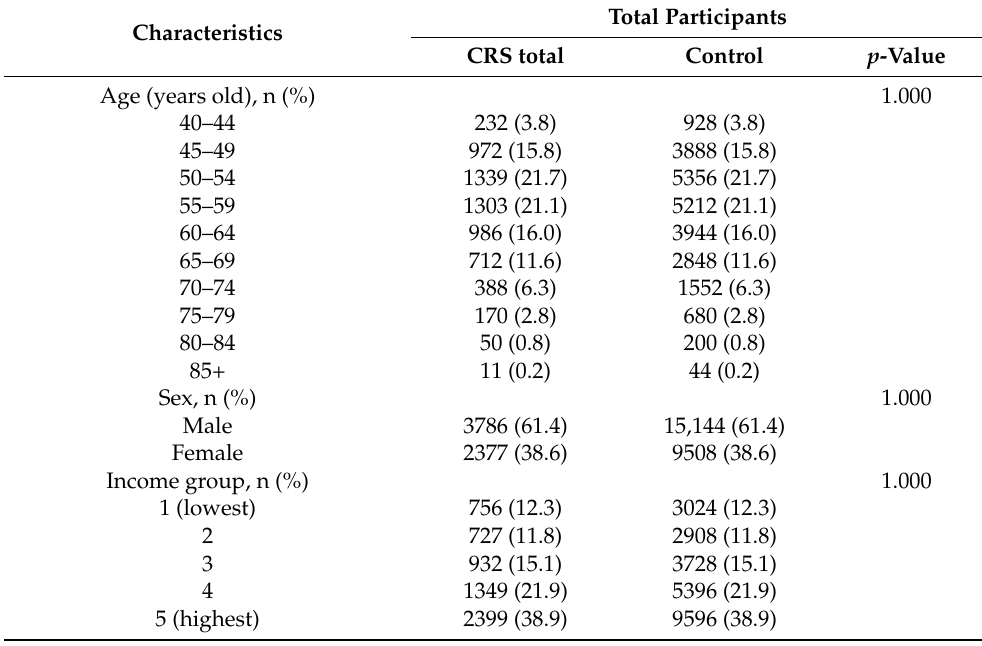
Table 1. General Characteristics of